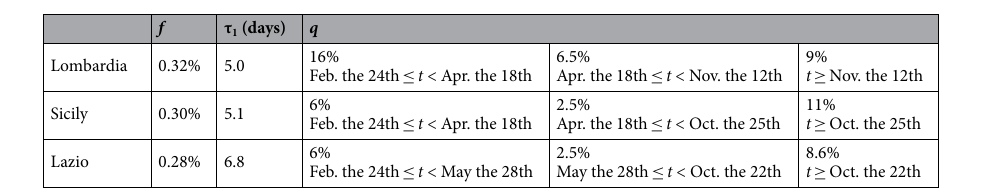
Table 1. Parameter values used to fit the theoretical model to the data shown in Fig.